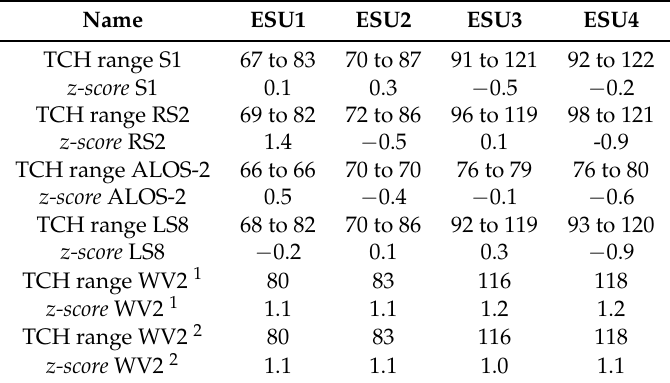
Table 4. TCH ranges between the first and last image in window of images of estimated TCH and associated z-score values per sensor for all ESUs of Field F2. 1 WV2 image taken 103 days after start of growth; 2 WV2 taken 301 days after start of